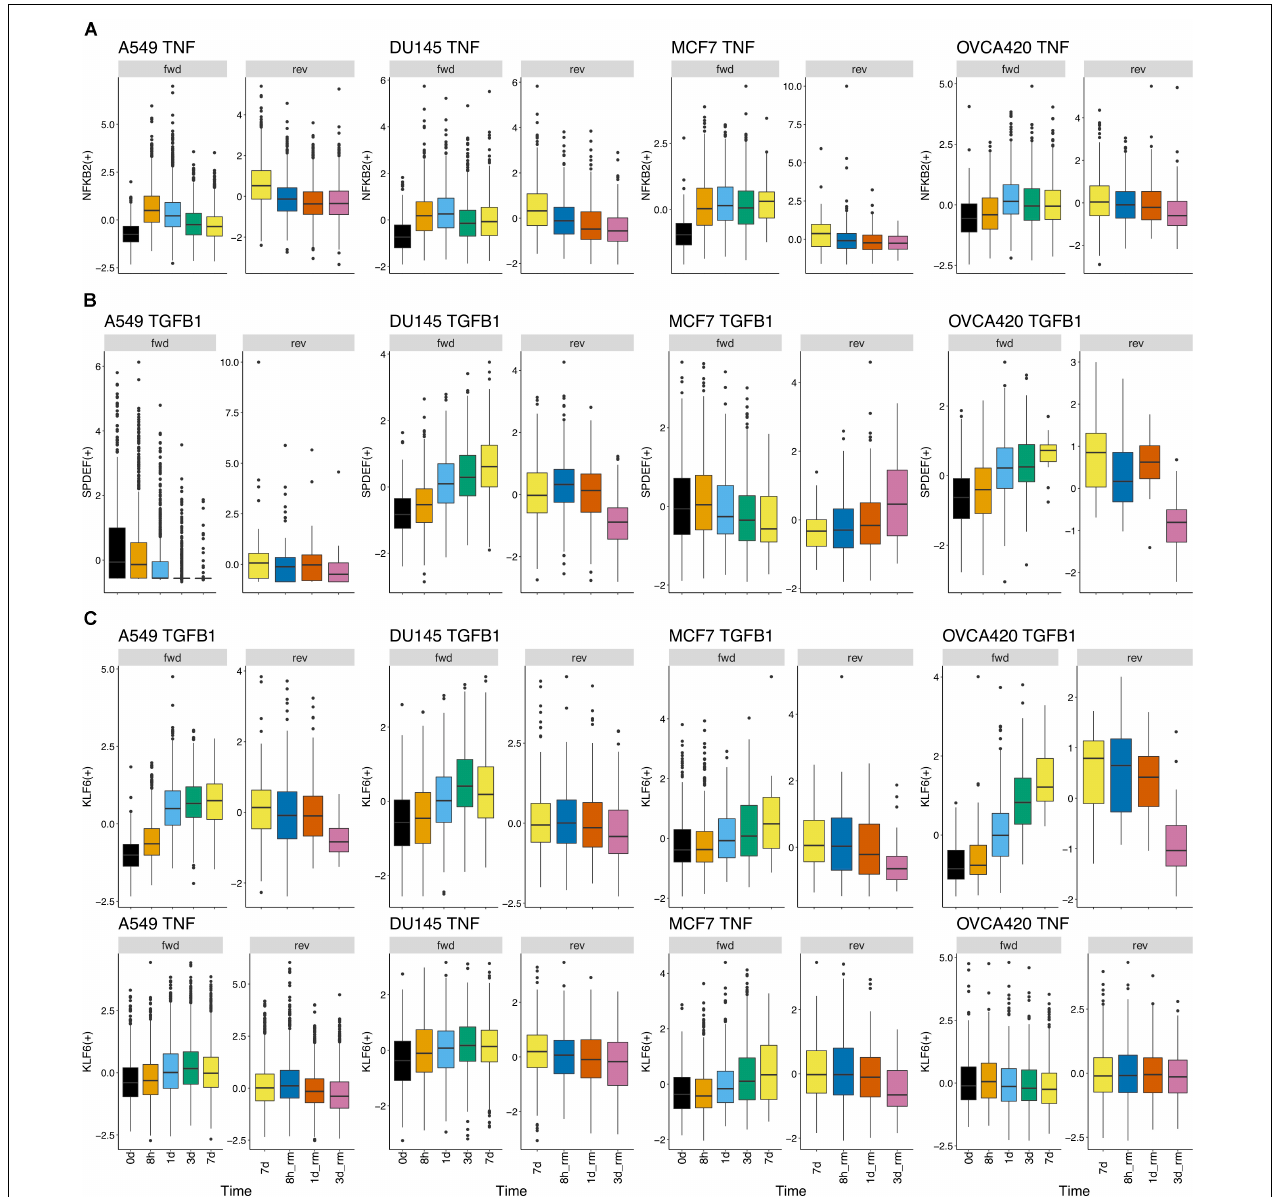
FIGURE 4 | Regulon activity profiles over time. (A) TF activity profile for NFKB2 over time in all cell lines treated with TNF. NFKB2 generally has similar gene activity dynamics across all cell lines treated with TNF. During signal induction, NFKB2 activity initially goes up and goes down at later time points; during signal removal, it gradually decreases. (B) TF activity profile for SPDEF over time in all cell lines treated with TGFB1. TGFB1 dynamics differ widely across cell lines; it acts like an M gene in DU145 and OVCA420, acts as an E gene in MCF7, and shows generally low activity in A549. (C) TF activity profile for KLF6 over time in all cell lines treated with TGFB1 or TNF. Across both cell lines and signal treatments, KLF6 activity follows a similar pattern throughout the transition: activity largely increases during the forward transition and decreases after signal removal.